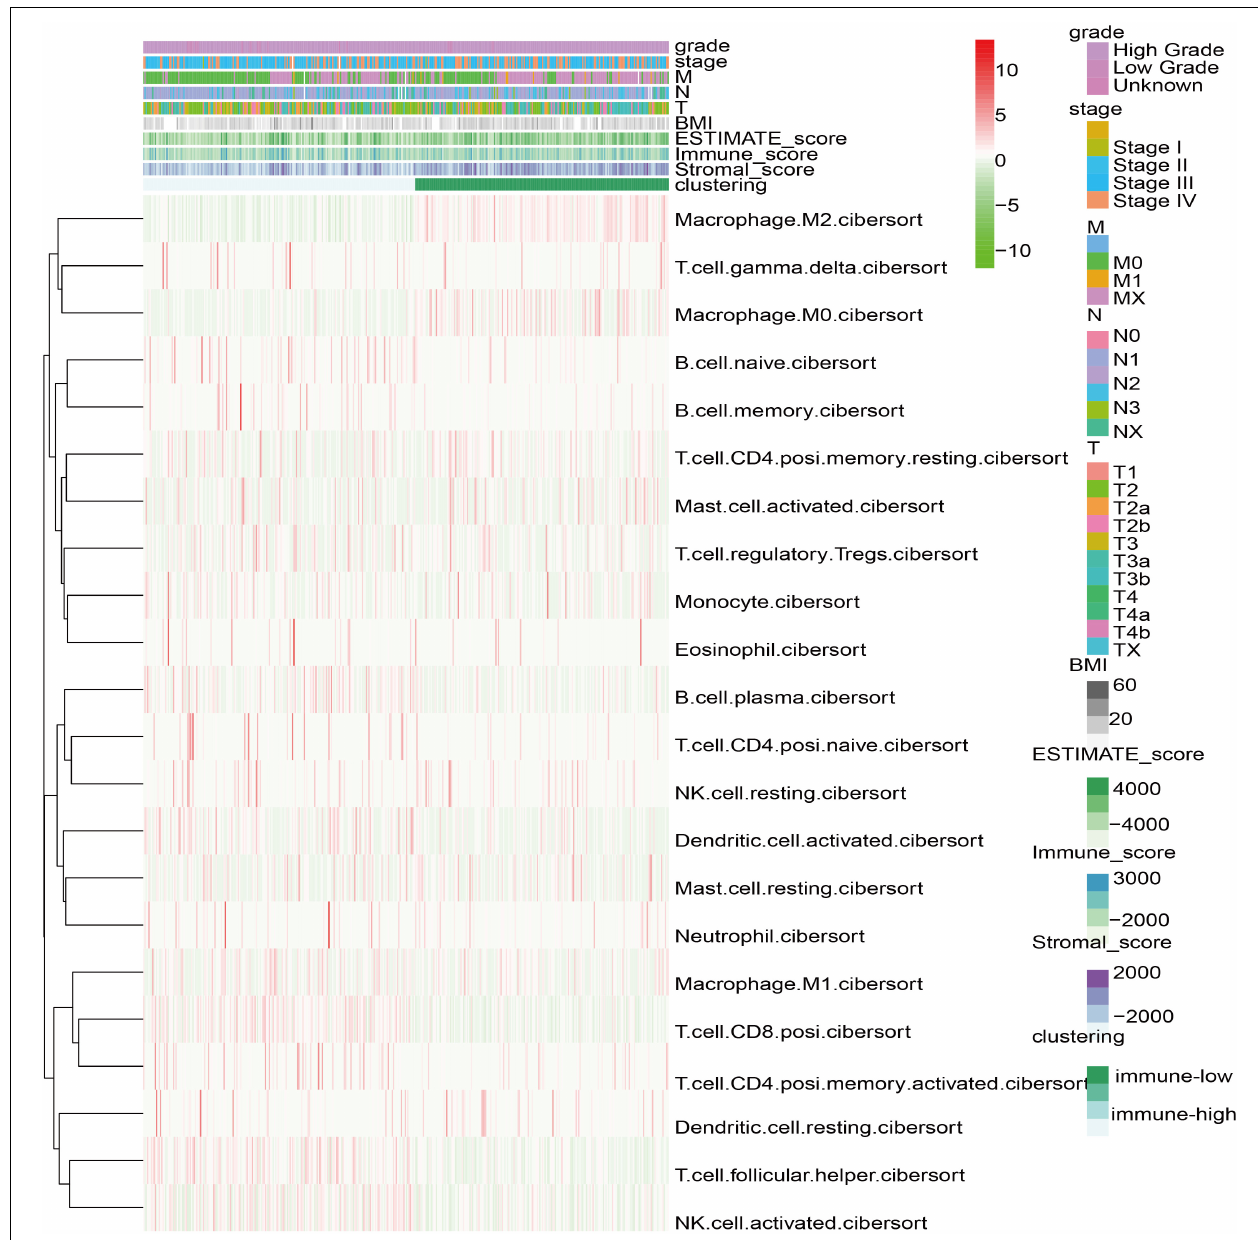
FIGURE 1 | Heatmap of 22 immune cell types based on immune microenvironment clustering. Missing clinical data are shown as blank on the top of the heatmap.